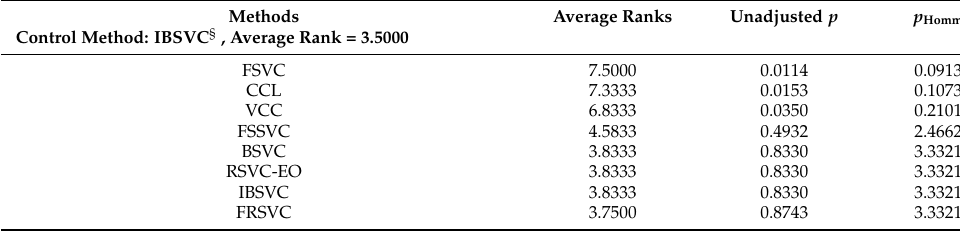
Table 5. Comparison under the non-parametric statistical test.